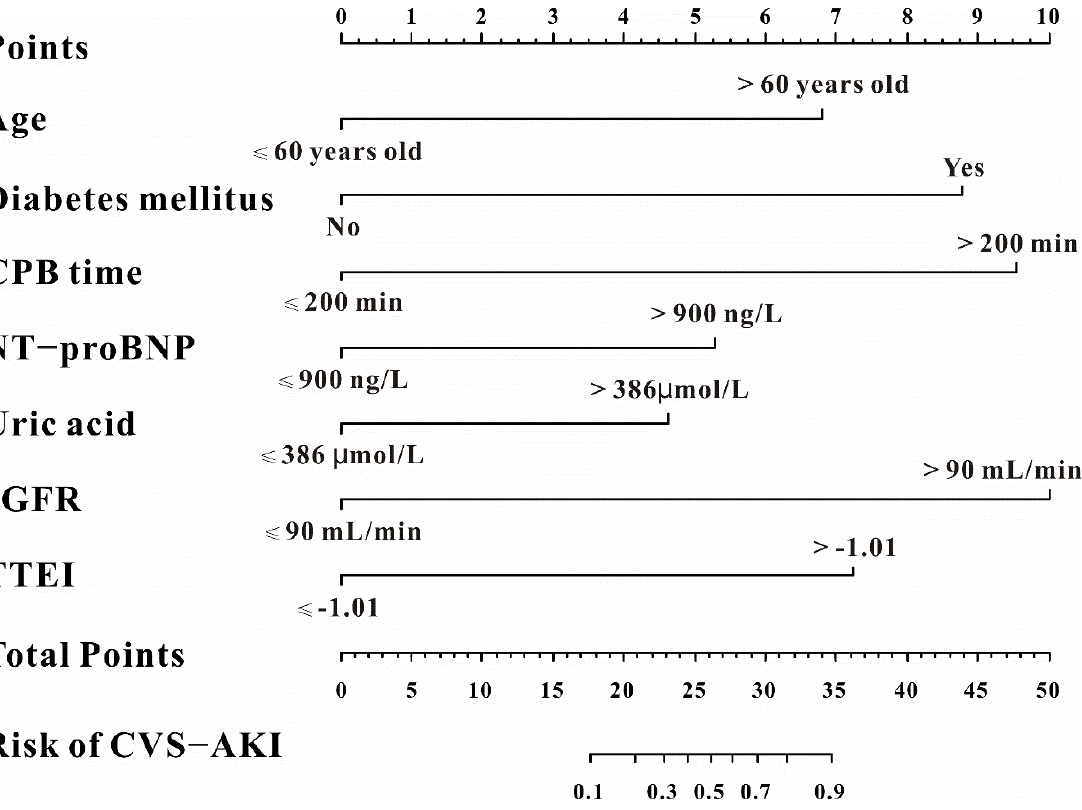
Figure 6. The predictive nomogram for CVS−AKI . Table 3. Logistic regression analysis for the predictors of CVS−AKI selected by LASSO regression.